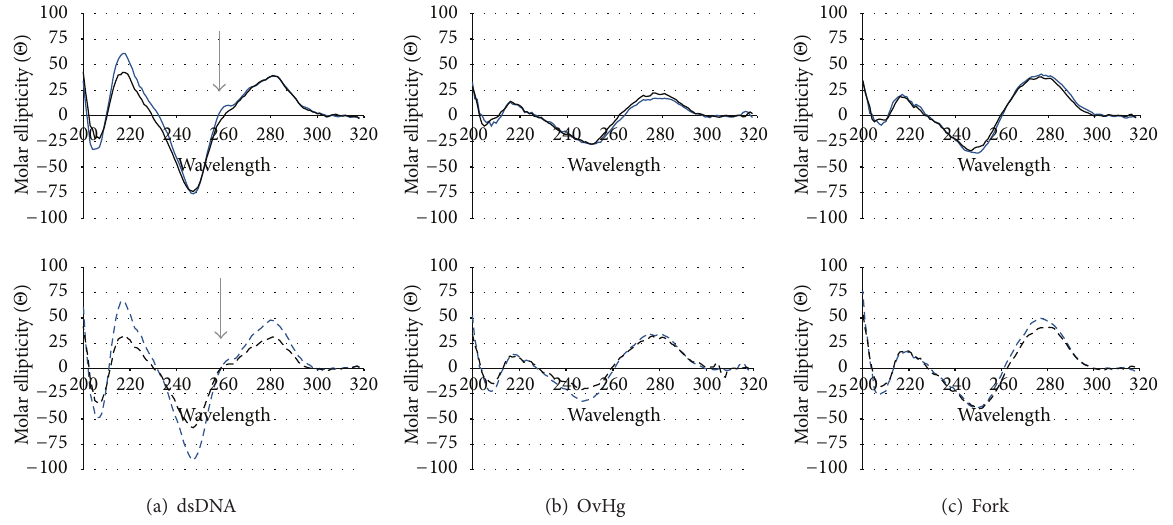
Figure 4: CD spectra comparing the effect of 3 on the secondary structure of replication relevant architectures. The top row shows the CD spectra for constructs of Sequence 1 (solid lines), while the bottom row shows the CD spectra for Sequence 2 (dashed lines). Constructs containing unmodified oligomers are represented in blue, while the constructs containing 3 are in black. (a) duplexes, (b) 5 󸀠 and 3 󸀠 OvHgs, (c)